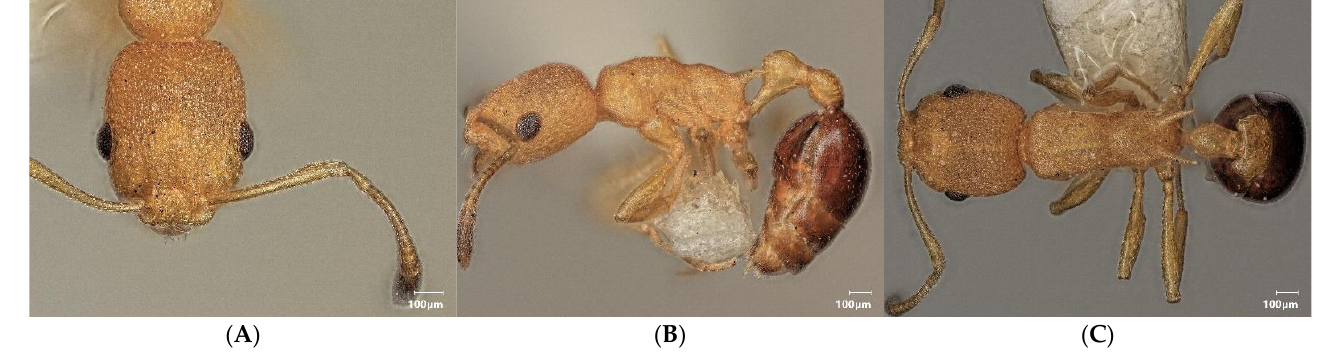
Figure 19. Cardiocondyla excavata n.sp., holotype: head in dorsal view ( A ), lateral view ( B ), dorsal view ( C ).